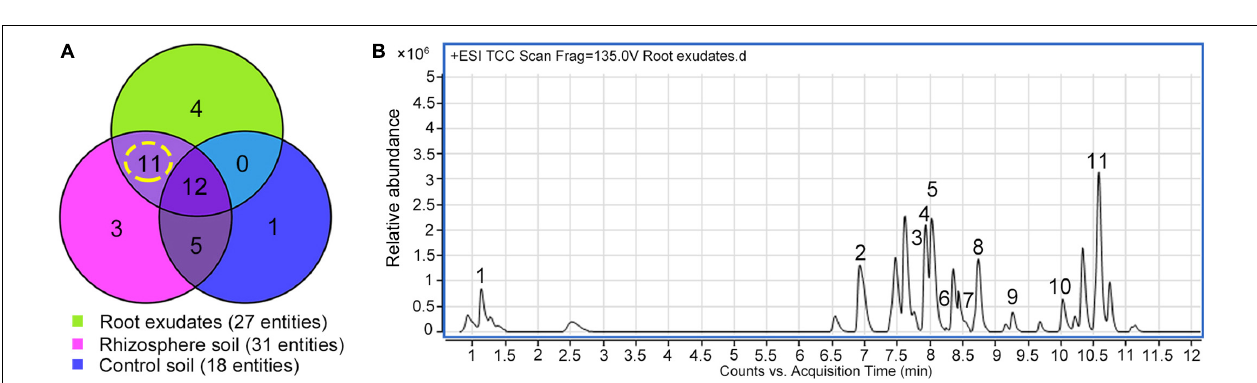
FIGURE 1 | Root exudates and colored epidermal tissues in seedling roots and mature tuber periderm of R. glutinosa . (A) Bright field image of root hairs of 7-day-old R. glutinosa seedling, showing releasing of yellow exudates. Bar, 50 µ m. (B) Bright field image of tuber surface of 180-day-old R. glutinosa , showing accumulation of yellow metabolites in the periderm (with periderm) and in cortex (without periderm). Bar, 0.5 cm.